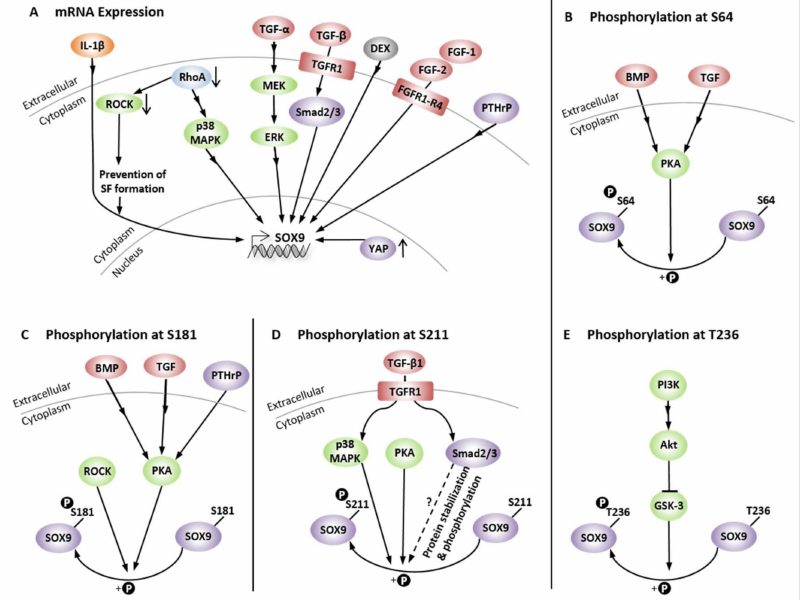
Figure 12. Regulation of SOX9 mRNA expression and SOX9 phosphorylation. ( A ) mRNA expression of SOX9 is induced through IL-1 β , TGF- α or - β , FGF-1 and -2, DEX, and PTHrP in specific conditions. ( B ) Phosphorylation at S64 by PKA is induced through BMP and TGF signaling. ( C ) Phosphorylation at S181 is performed by ROCK and PKA; the latter is induced through BMP, TGF, and PTHrP signaling. ( D ) Phosphorylation at S211 is performed by PKA and p38 MAPK as well as mediated through TGF- β 1 and Smad2/3 signaling. ( E ) Phosphorylation at T236 by GSK-3 is regulated through PI3K/Akt signaling. Signaling pathways and kinases involved in SOX9 phosphorylation are in part listed by [301]. Details are specified in the text. Abbreviations: BMP: bone